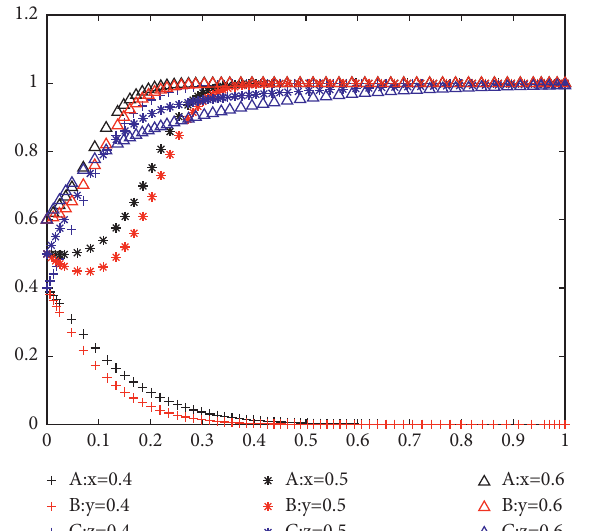
Figure 1: Evolutionary analysis of the simultaneous changes of the initial willingness to participate in cooperation ( x ), ( y ), and ( z ).